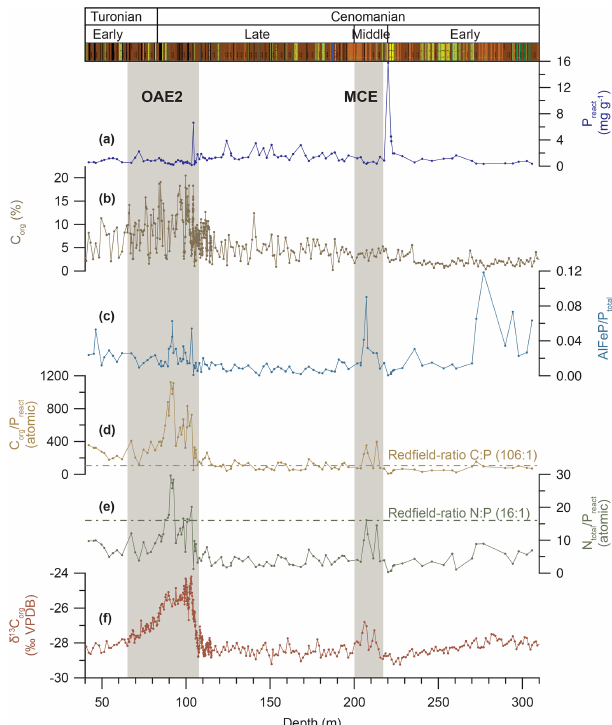
Figure 7. Phosphorus speciation in Tarfaya Basin Core SN ◦ 4. (a) Concentration of reactive phosphorus (P react ) calculated as the sum of Al / Fe- and Ca-bound P. (b) Concentration of organic car- bon (C org ). (c) Ratio of aluminium- and iron-bound phosphorus to total phosphorus (AlFeP / P total ). (d) Atomic ratio of organic car- bon to reactive phosphorus (C org / P react ) with Redfield ratio 106 : 1 indicated as a dashed line. (e) Atomic ratio of total nitrogen to reac- tive phosphorus (N total / P react ) with Redfield ratio 16 : 1 indicated as a dashed line. (f) δ 13 C org from Kuhnt et al. (2017) and Beil et al.